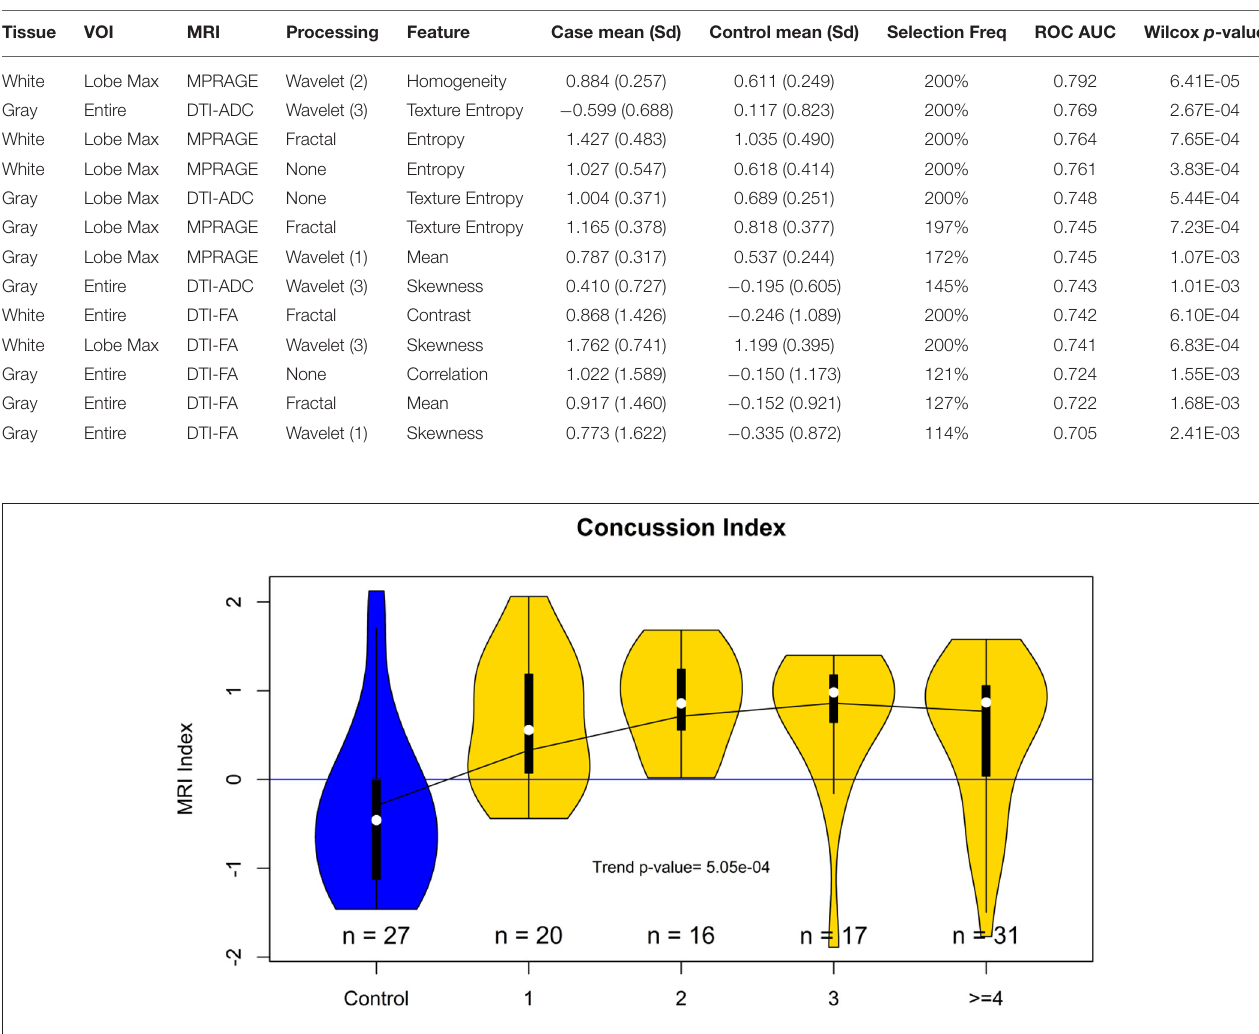
TABLE 7 | Top features associated with PCS.